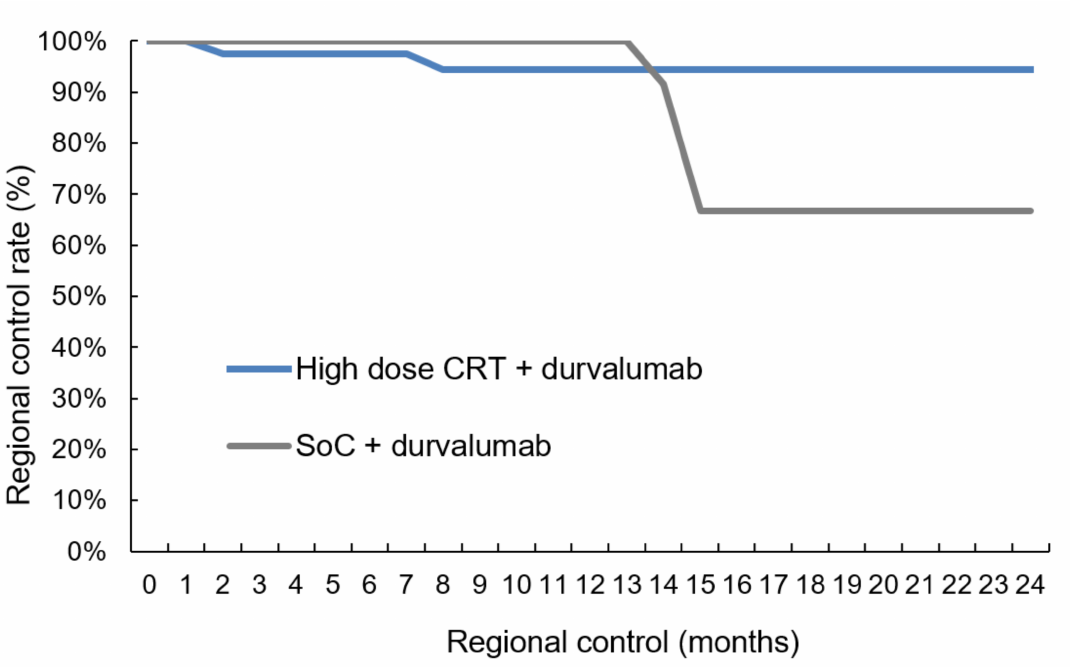
Figure 3. Regional control. The comparison revealed no difference in regional control between high- dose chemoradiation and SoC treatment (log-rank test, p -value = 0.313): CRT = chemoradiotherapy, SoC = standard of